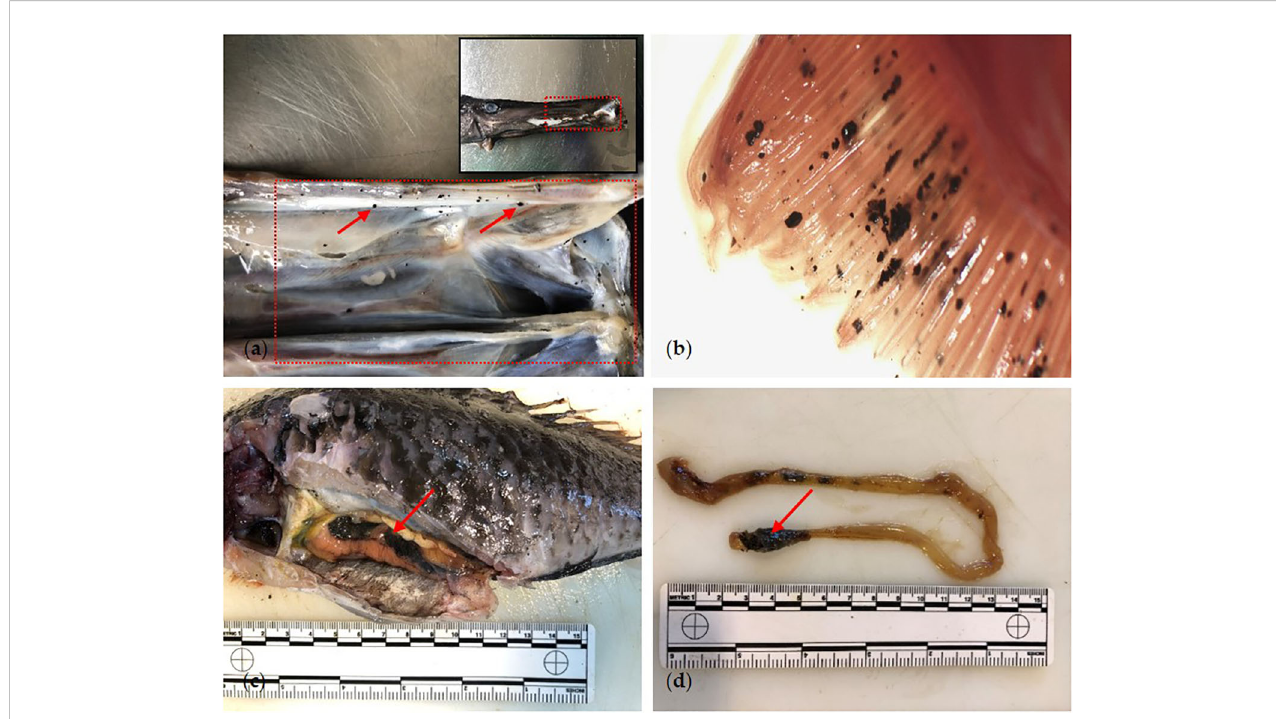
FIGURE 5 Macroscopic fi ndings in fi shes from La Palma volcano. (A) Volcanic particles ( ! ) in the oral cavity in a specimen of Aulostomus strigosus . (B) Severe deposition of volcanic particles in the gill from a specimen of Stephanolepis hispida . (C) Presence of volcanic material ( ! ) in the intestine of Sparisoma cretense . (D) Severe impaction of volcanic material ( ! ) in the intestine of Stephanolepis hispida